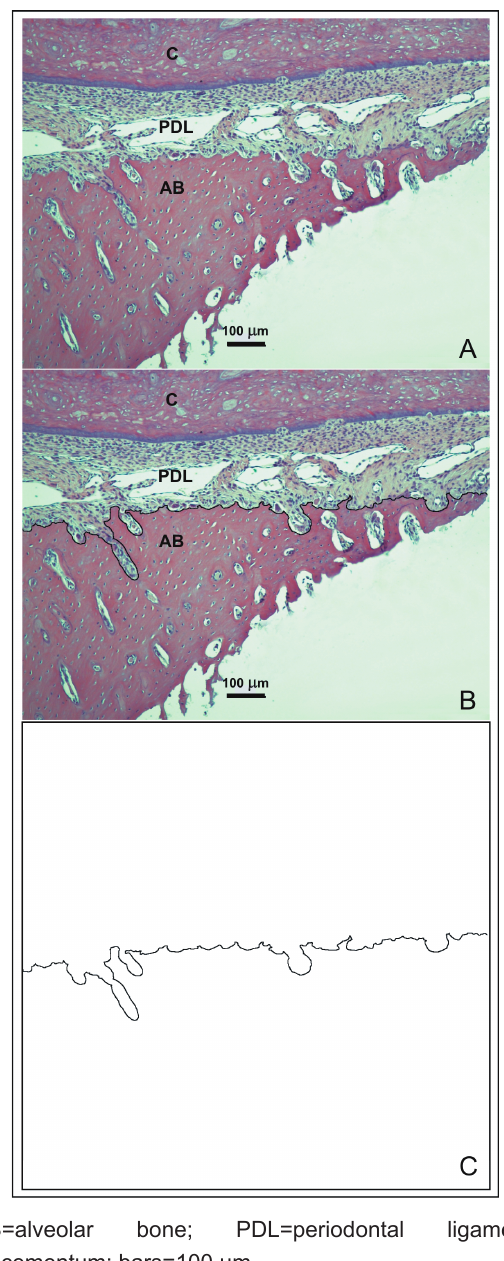
AB=alveolar bone; PDL=periodontal ligament; C=cementum; bars=100 Figure 1- Obtention of the periodontal ligament (PDL)- bone interface contour. A: micrographs captured with a 10x objective lens of the PDL-bone interface of the mesial of the lower first molar; B: PDL-bone interface outlined; C: image used to calculate the fractal dimension